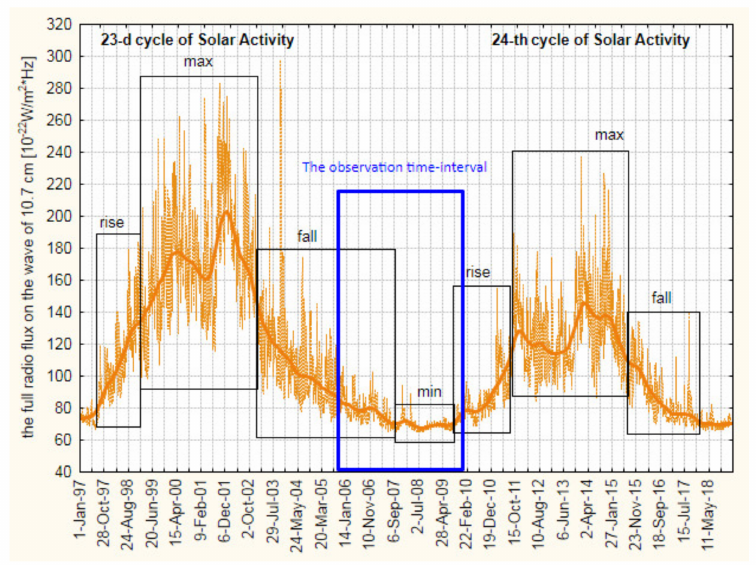
Figure 3. The position of the observation time interval on the line of the solar activity